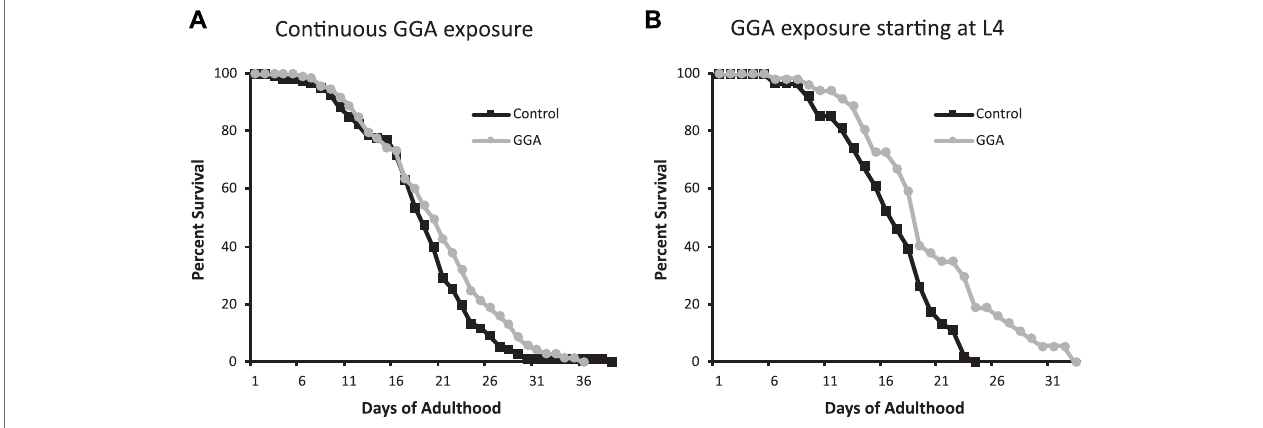
FIGURE 4 | GGA extends lifespan in C. elegans . Wild-type (N2) worms were synchronized and incubated on NGM control plates or plates containing 10 μ M GGA startingattheL1 (A) orL4 (B) larvalstages.Wormswerescoredforviabilitystartingatday1ofadulthood.WormsexposedtoGGAineithercaselivedsigni fi cantlylonger